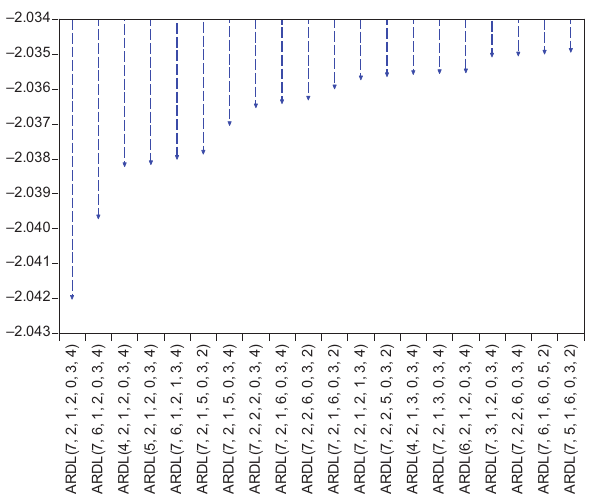
Figure 1. Selection of appropriate lag length for ARDL bounds test (source: own calculation of author) ARDL bounds test results for the determined (7,2,1,2,0,3,4) model are given in Table 4. F-statistic is greater than the upper limit critical value at the 1% significance level. There-